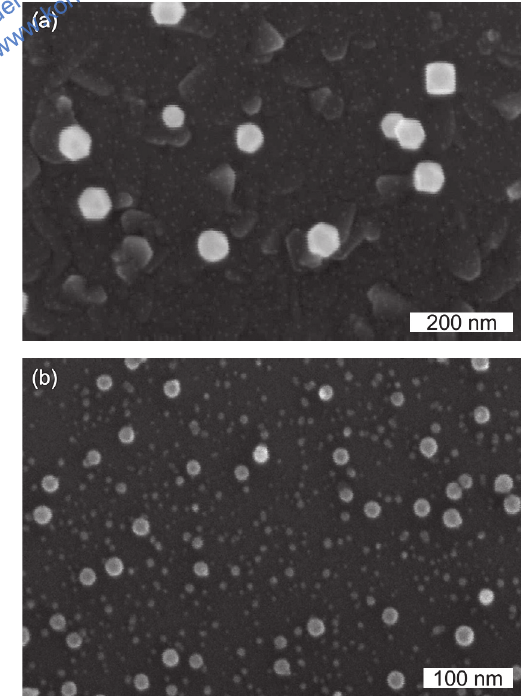
Fig. 6 SEM micrographs of ( a ) silver and ( b ) copper nanopar- ticles. The silver nanoparticles have cubic and facetted shapes whereas the copper nanoparticles are spherical and, in this case, with a wide spread of the size distri- bution.